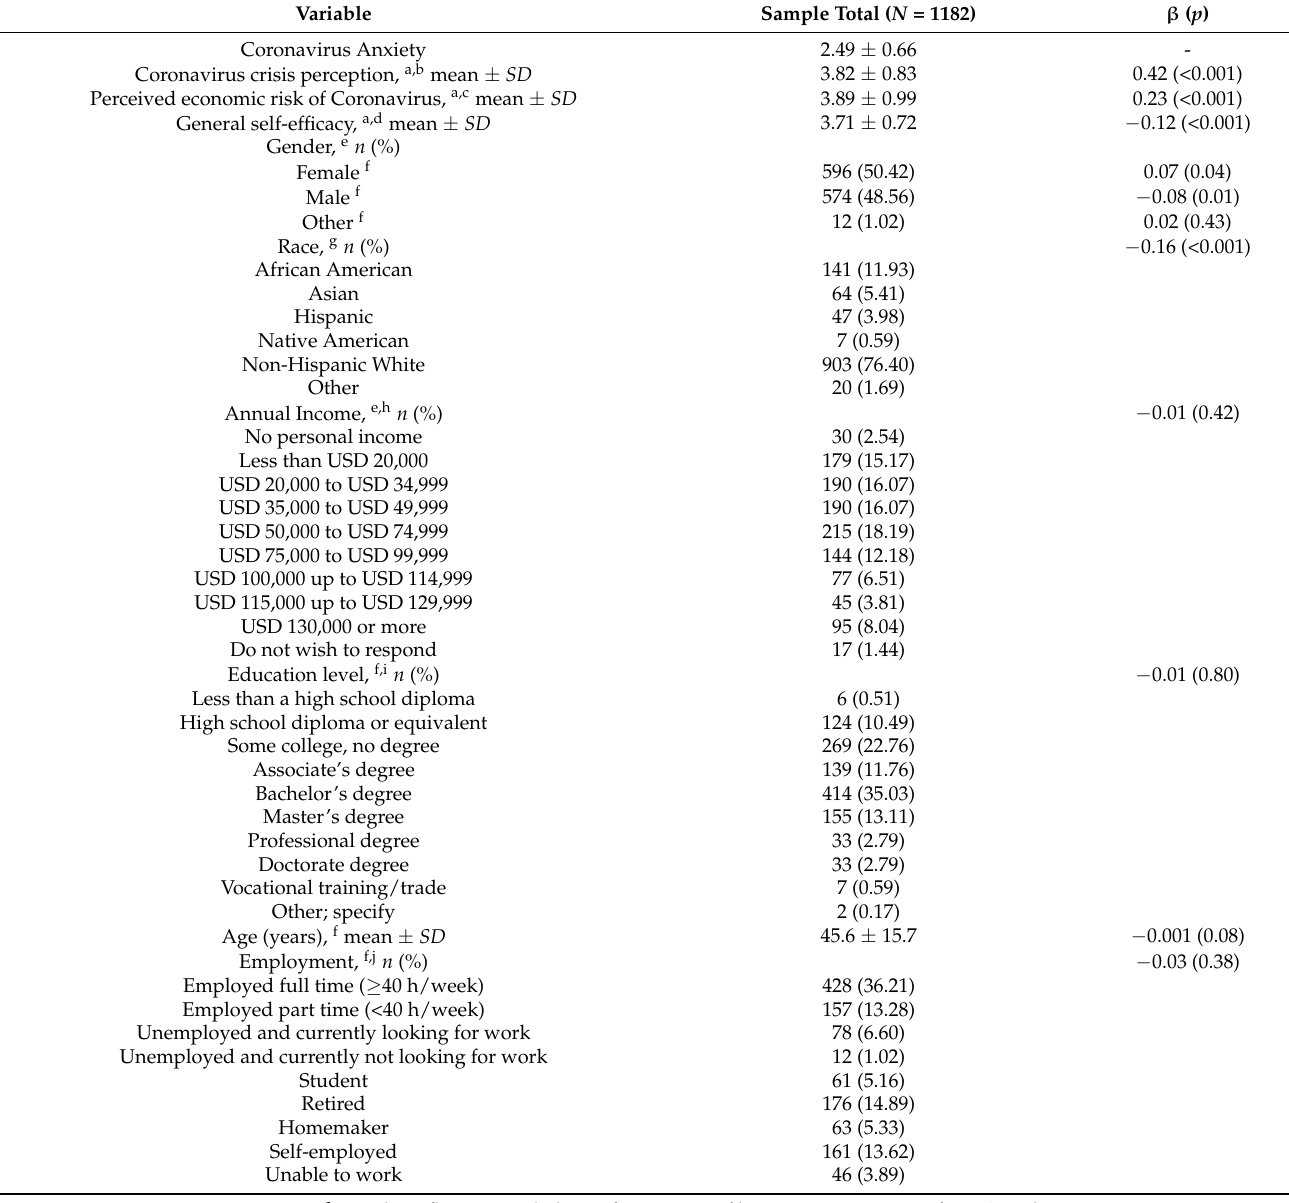
Table 1. Descriptive Characteristics of Participants by Coronavirus